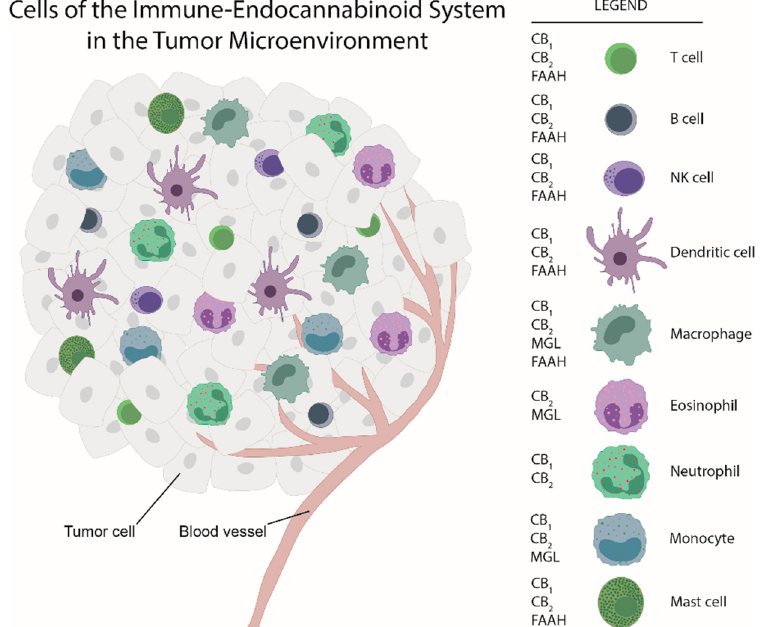
Figure 1. Tumors locally recruit immune cells that reject and also promote tumor development and metastasis. Immune cells express components of the endocannabinoid system, thereby they are able to form an “immune endocannabinoid system” within the tumor microenvironment. Most of the immune cells express cannabinoid receptors (CB 1 , CB 2 ) and enzymes for endocannabinoid degradation (monoacylglycerol lipase (MGL) and fatty acid amide hydrolase (FAAH)). In addition, they are known to release endocannabinoids (see Table 2).